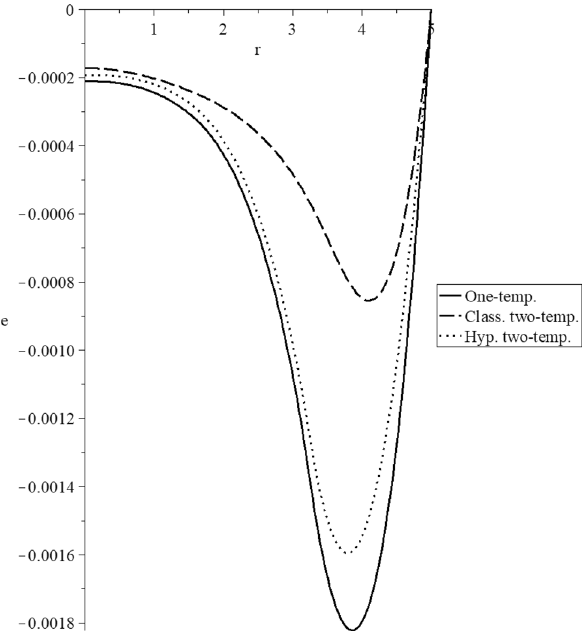
Figure 5. The volumetric deformation distribution for different models.